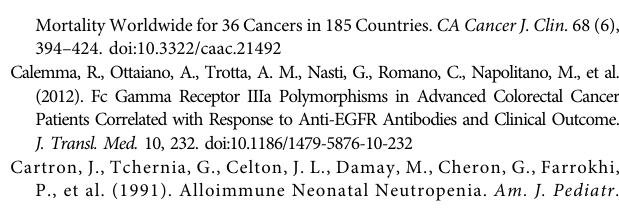
Supplementary Figure S1 | The expression of FCGR3A in different TCGA cancer types was analyzed using TIMER (A) and GEPIA2 (B) respectively. Supplementary Figure S2 | The expression of FCGR3A in pan-cancer single cell lines was analyzed using GDSC database (A) and the cancerSCEM website (B)